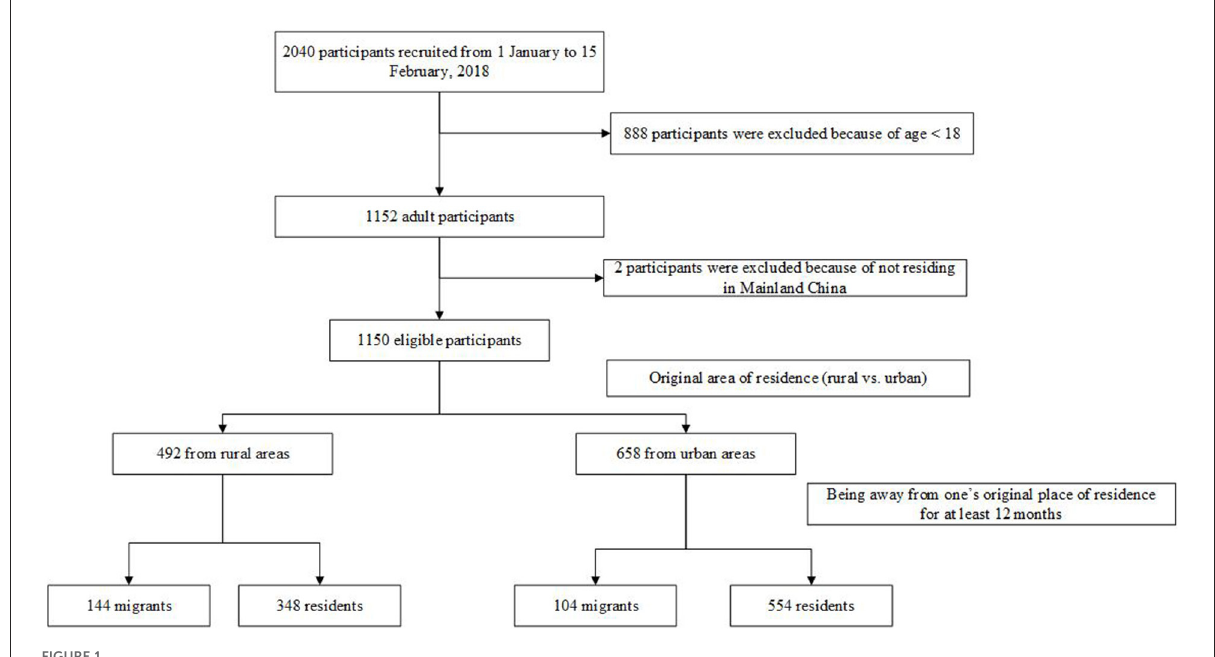
FIGURE1 Construction of the study